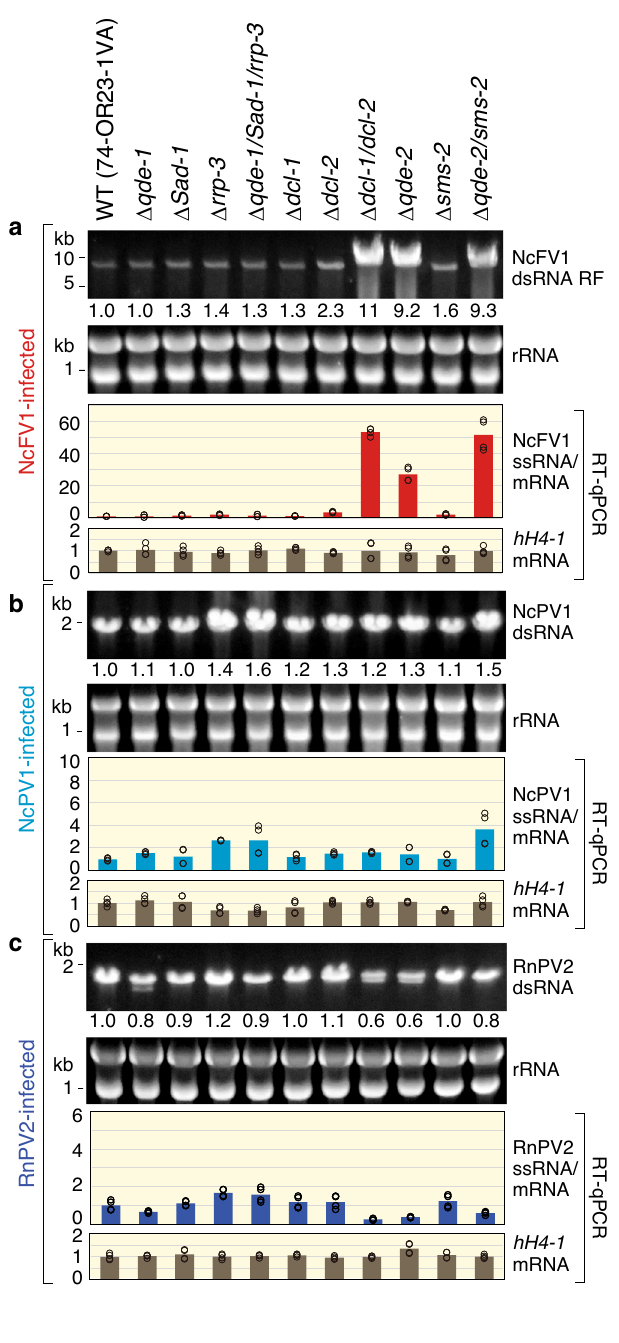
the aforementioned virus hunting (see Supplementary Table 1).